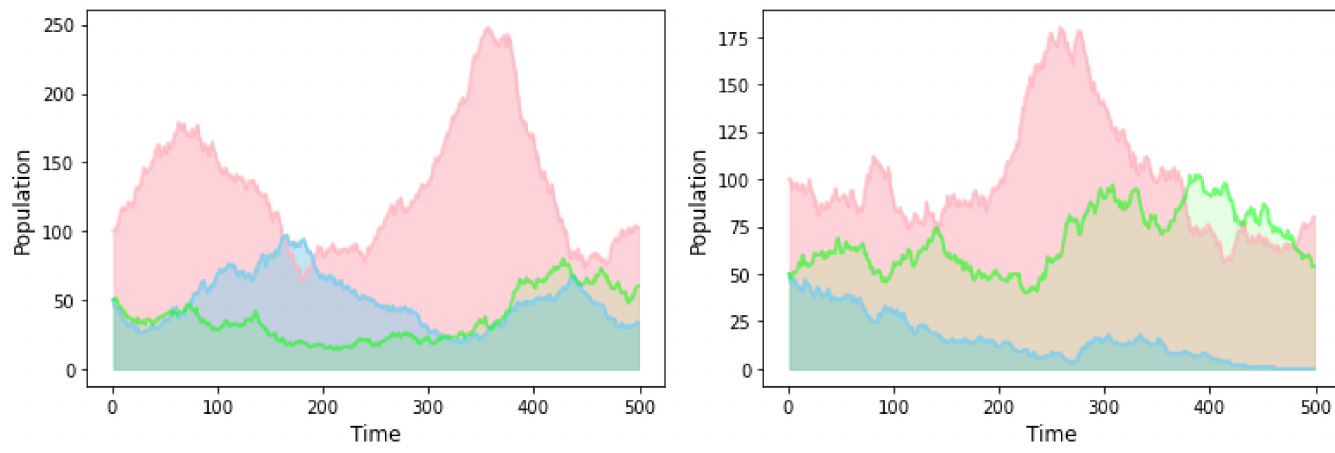
Fig 3. Population dynamics throughout a simulated game. The effect of nonlocal correlations on cell (red) and virus (blue and green) communities is depicted by comparing the evolution of the species’ populations over time in a simulation. On the left, viruses from both communities, the blue and green, are equally correlated with their host cells. In this case the entire system is stable and the communities all survive. The right plot illustrates the case where viruses from one community (green) are coordinated with their host cells to the extent permitted by quantum mechanics (above any classical correlation). Due to monogamy of correlations, the blue virus community exhibit lack of coordination with their host cells which ultimately leads to the extinction of the blue